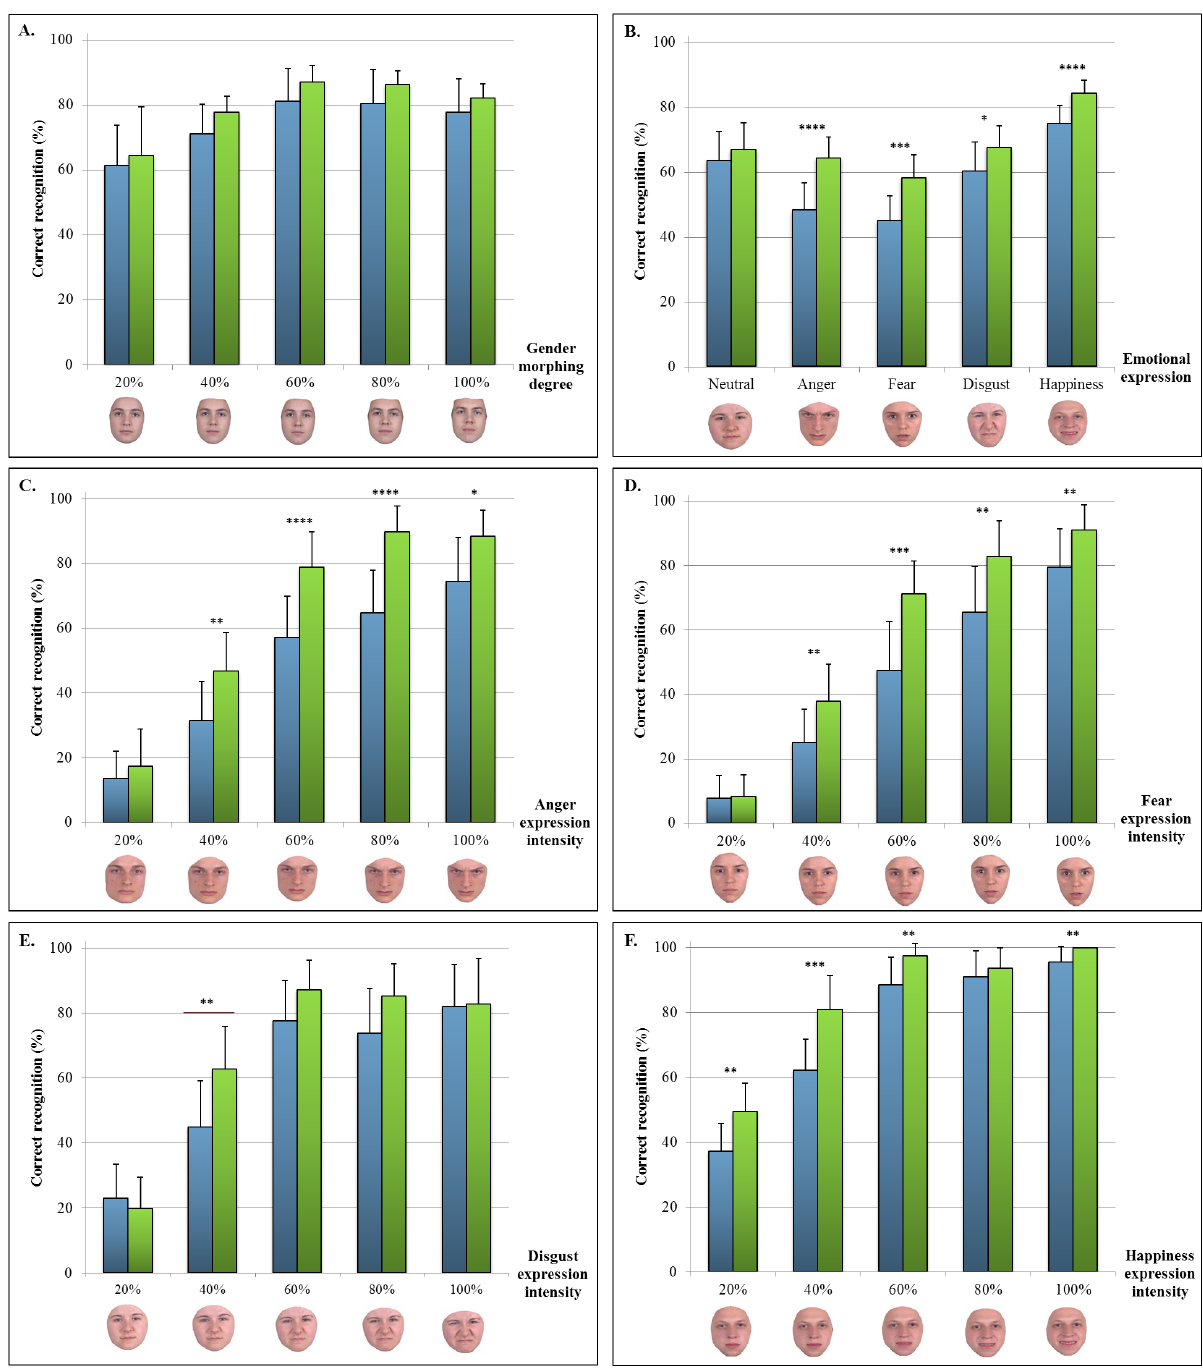
Fig 2. Mean performance on cognitive tasks. A: Gender recognition; B: Emotion recognition; C: Anger recognition; D: Fear recognition; E: Disgust recognition; F: Happiness recognition. Examples of morphed faces depicting various intensities of the emotional expression are shown at the bottom of each graph. Blue: patients (AD at the MCI stage or at the mild dementia stage); Green: controls. * p < .05; ** p < 10 – 2; *** p < 10 – 3; **** p < 10 – 4.